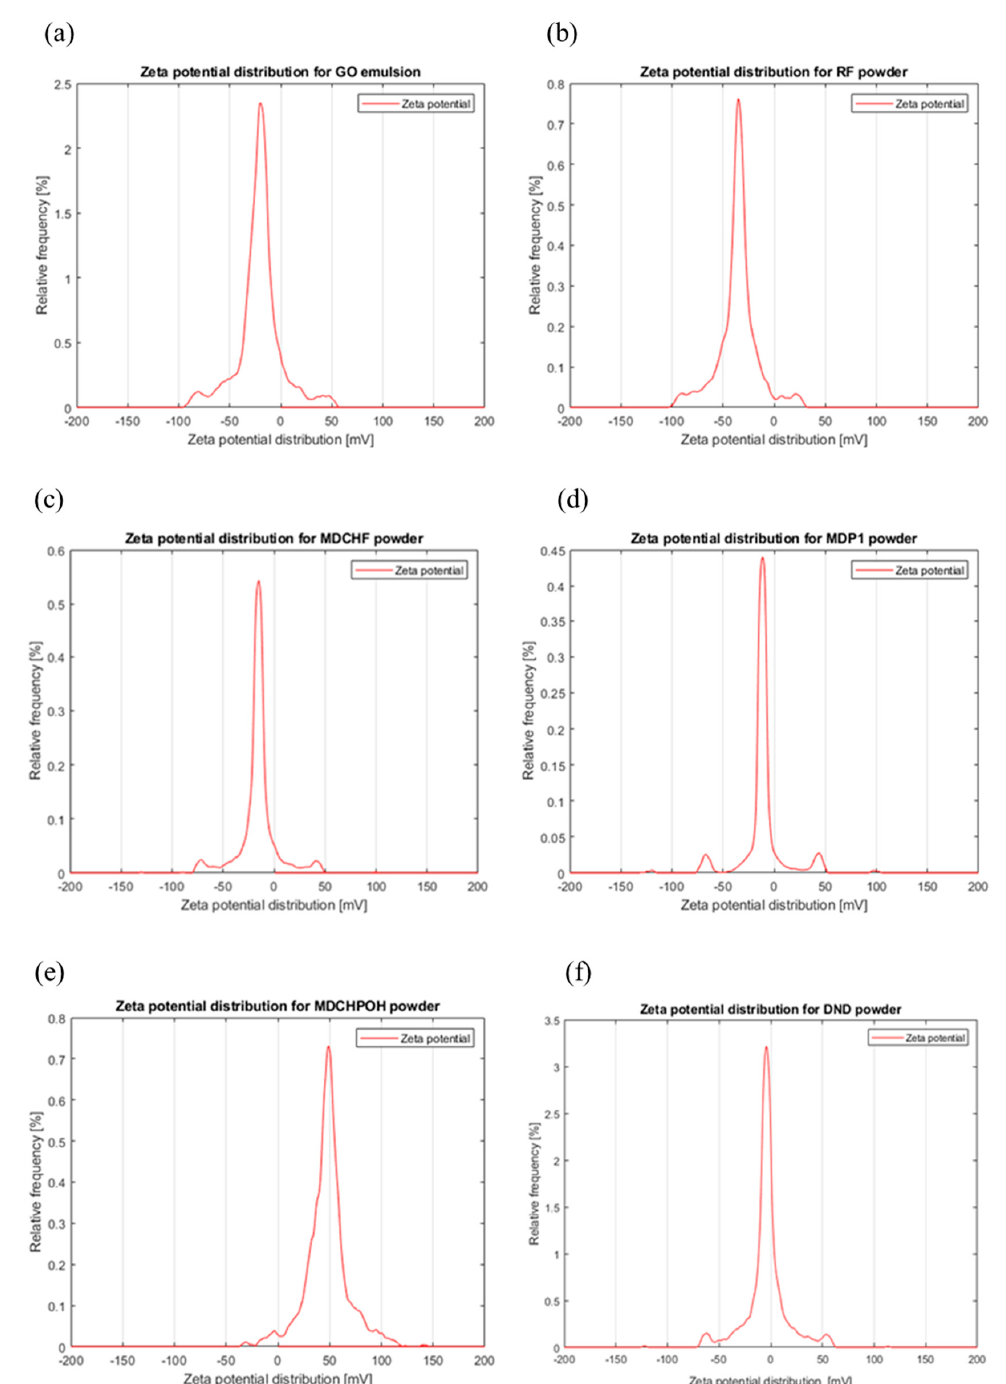
Figure 9. Zeta potential of Carbon-based Nanomaterials: ( a ) Graphene Oxide (GO) emulsion; ( b ) amorphous carbon powder formed using Radio Frequency Plasma Activated Chemical Vapor Deposition Method (RF); ( c ) fluorescent nanodiamond (MDCHF), ( d ) plasma–chemically modified detonated nanodiamond particles (MDP1); ( e ) chemically modified detonated nanodiamond particles with hydroxyl functional groups (MDCHPOH); ( f ) pure detonated nanodiamond particles (DND).